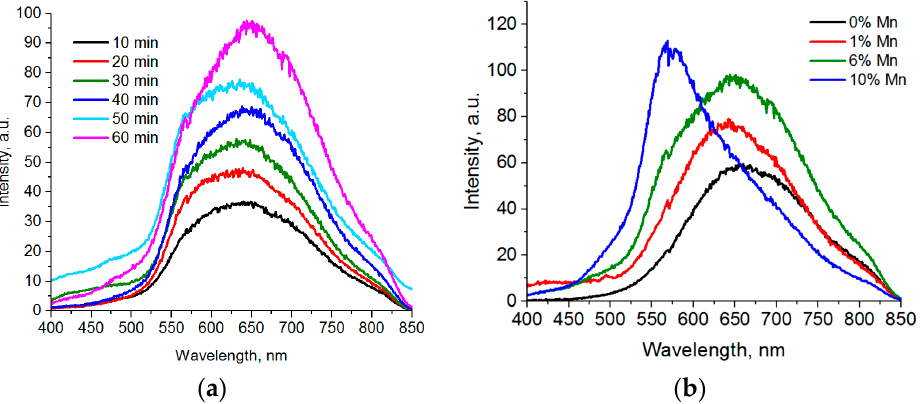
Figure 5. ( a ) Luminescence spectra of Cd 0.94 Mn 0.06 S QDs taken at various times after the start of synthesis; ( b ) the dependence of the Cd x Mn 1-x S luminescence collected after 60 min of synthesis on the amount of manganese ions.